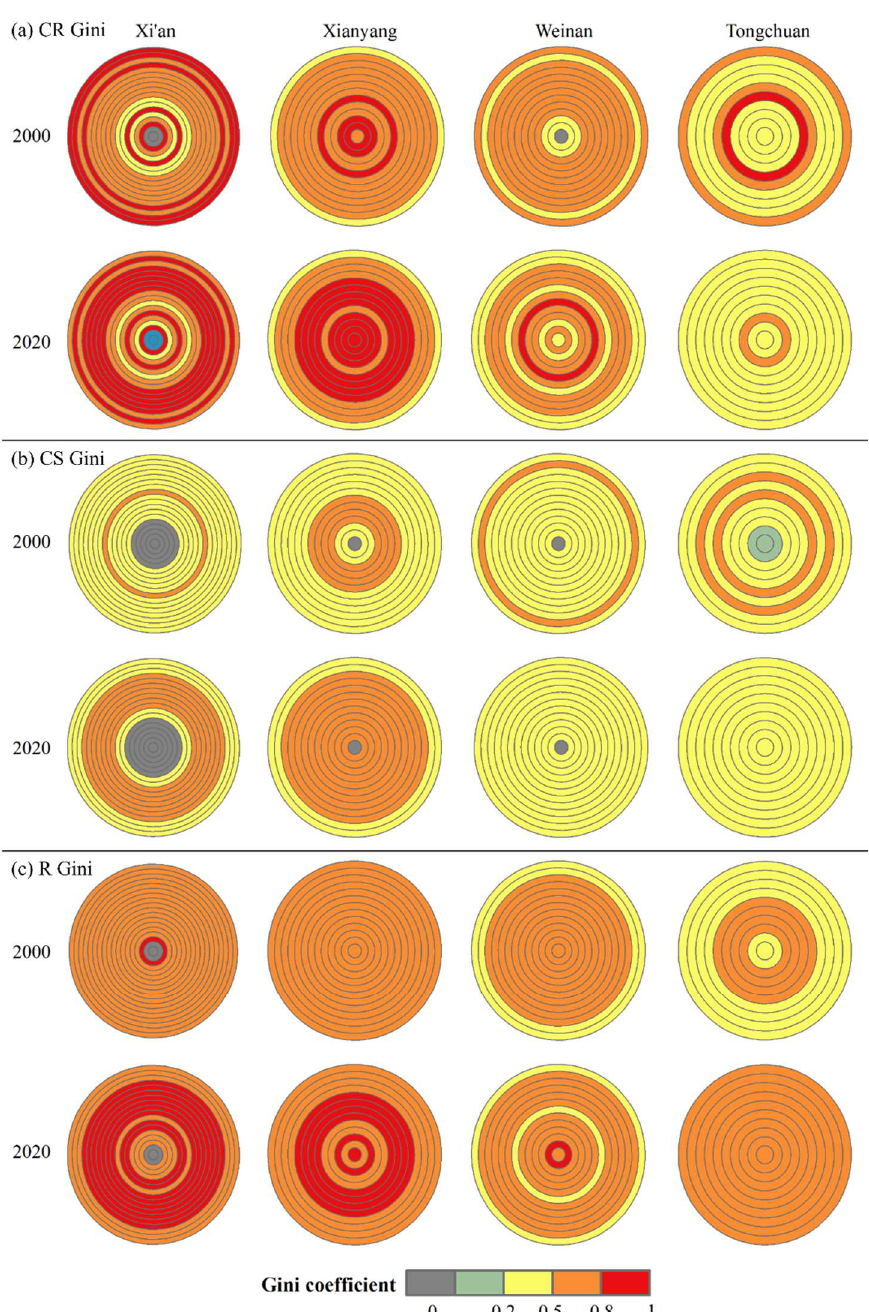
Figure 10. The spatial patterns of Gini coefficients of ( a ) climate regulation (CR), ( b ) carbon sequestration (CS), and ( c ) recreation (R) in 2000 and 2020 along urban–rural gradients in the XMA.